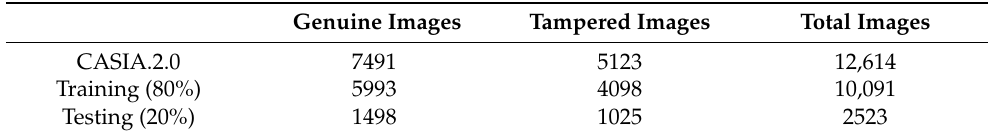
Figure 1. Various sample images and their processed forms: ( a ) the original images (RGB colour format); ( b ) the images with forgery (RGB colour format); ( c ) the recompressed forged images (RGB colour format); ( d ) ground truth of forgery (Binary format); ( e ) difference of the tampered image with its recompressed image (RGB colour format). Table 1. Details of the CASIA.2.0 image forgery